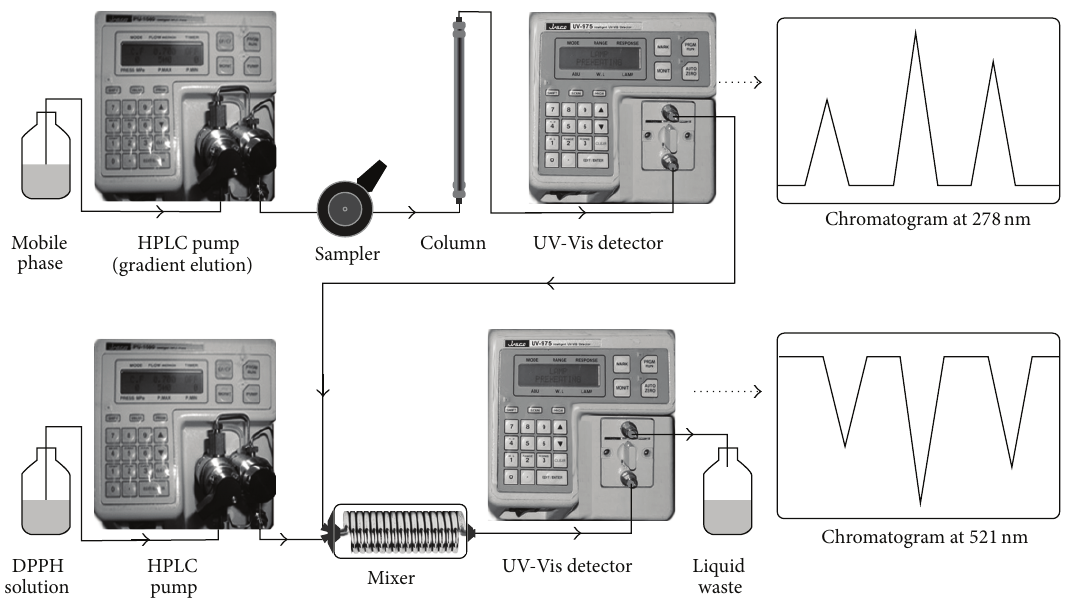
Figure 2: Instrumental setup for the HPLC analysis of radical-scavenging compounds using an online reaction with 1,1-diphenyl-2-picryl- hydrazyl (DPPH).